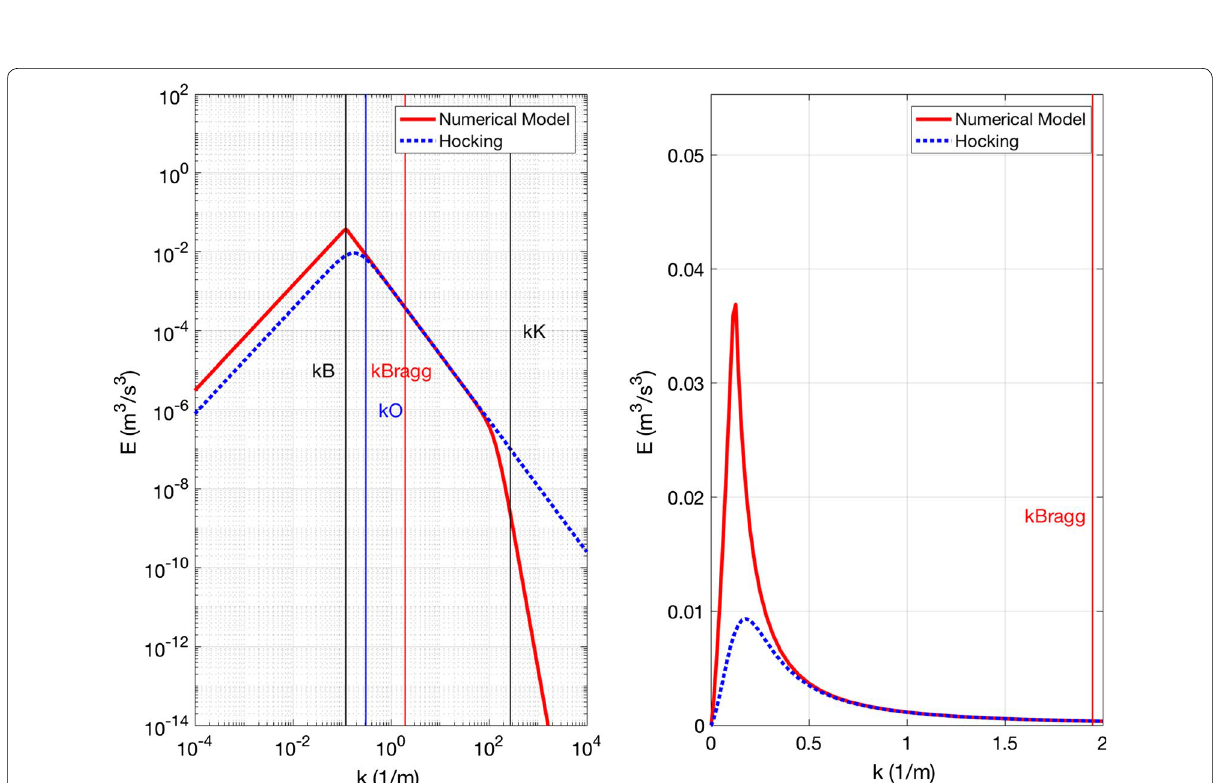
25 m ( f K 1, N 0.0121 s − 1 ). These values = = =